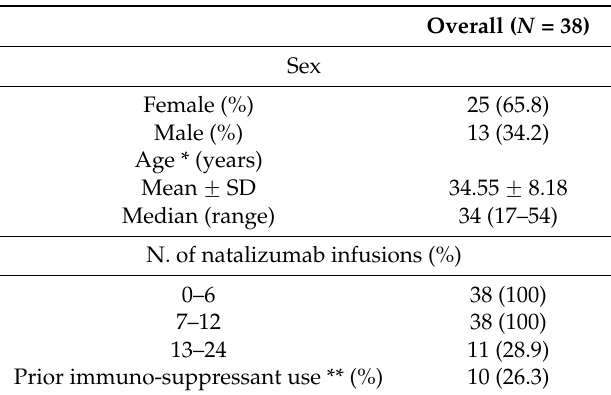
Table 1. Patients’ demographic